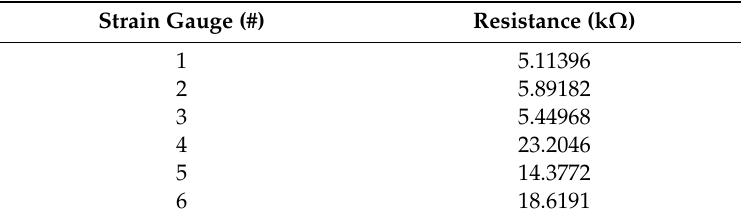
Table 2. Data for the resistance of the carbon paste-based strain